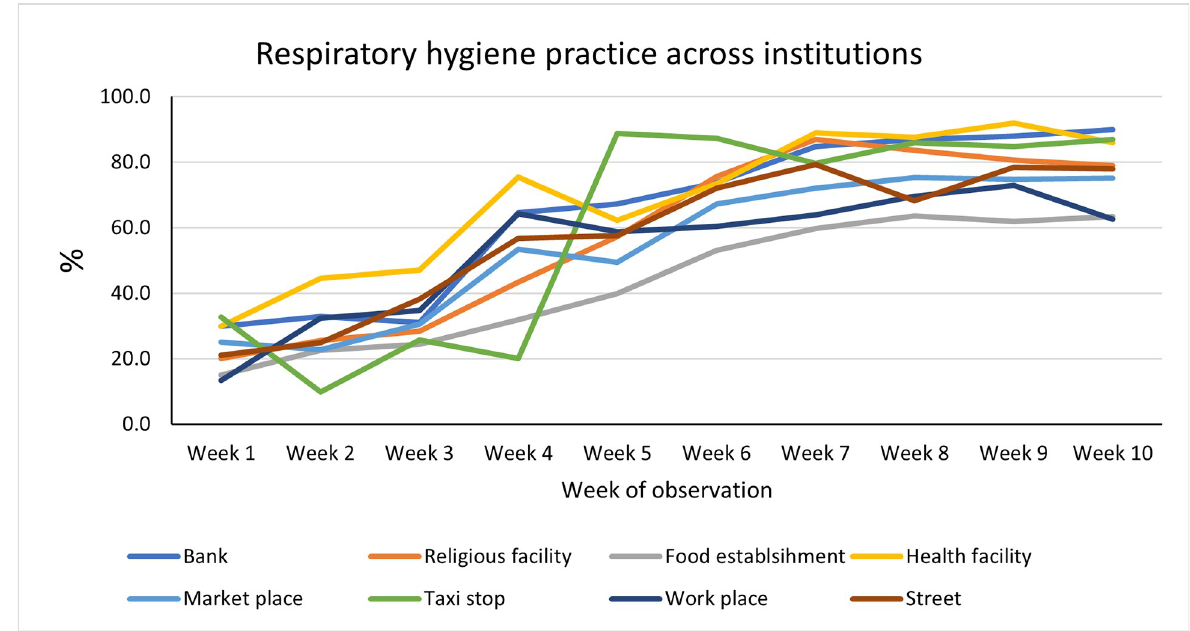
Fig 3. The trend of the proper respiratory hygiene practices by public